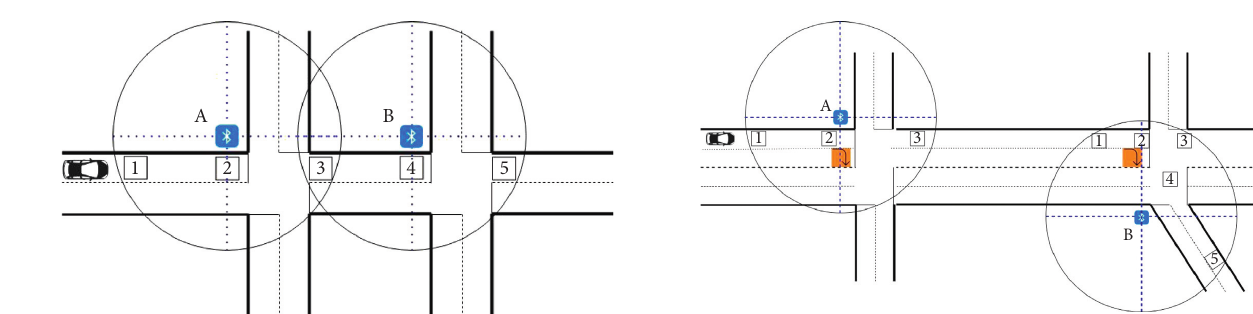
Figure 5: Illustration of scenario two of a vehicle on a signalised arterial link.